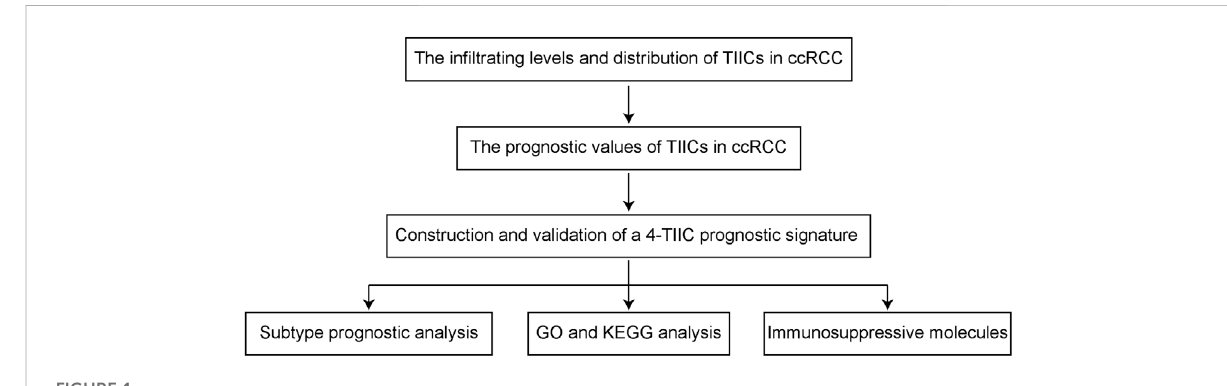
FIGURE 1 The fl ow chart of the current